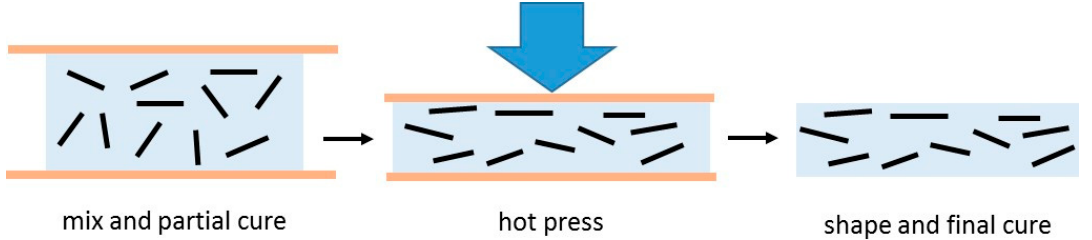
Figure 10. Schematic illustration of the hot-pressing procedure used to introduce orientation into epoxy-BN composites.